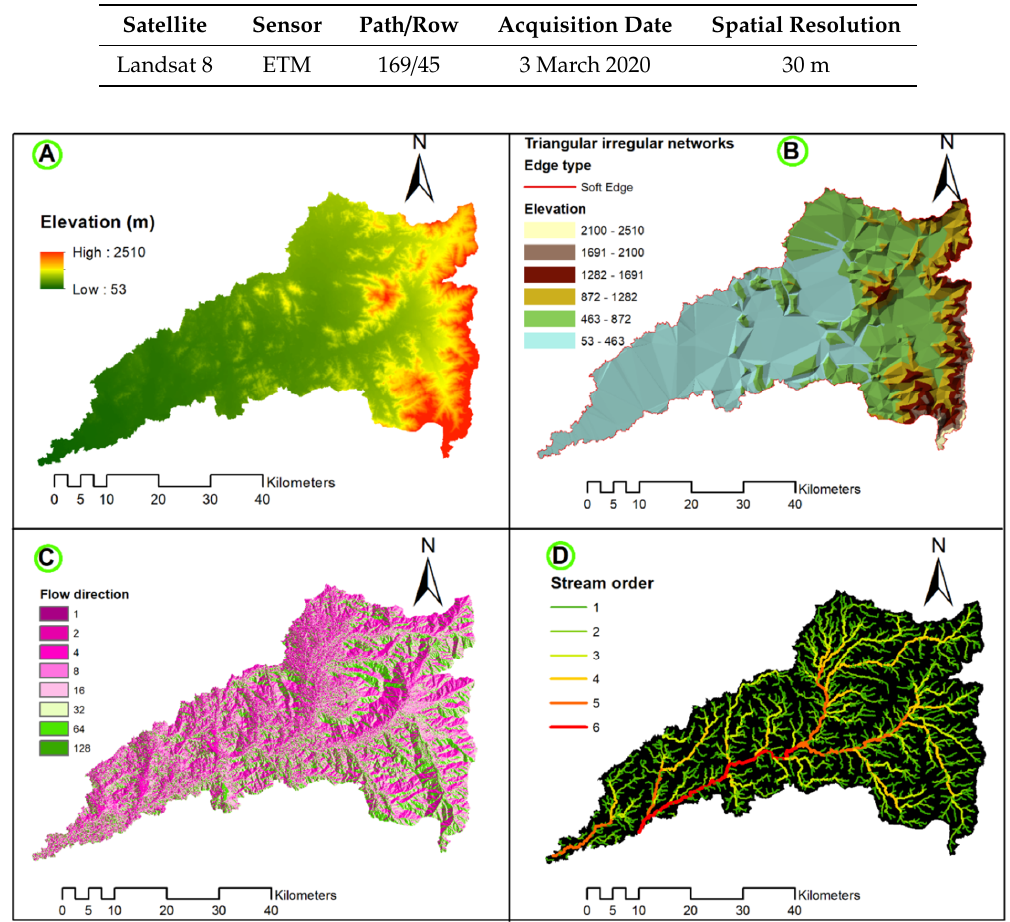
Figure 2. Extraction of drainage network for the study region (Wadi-Uranah). ( A ) Digital elevation model map of the study area; ( B ) triangular irregular networks map of the study area; ( C ) flow direction map of the study area; ( D ) stream order map of the study area.